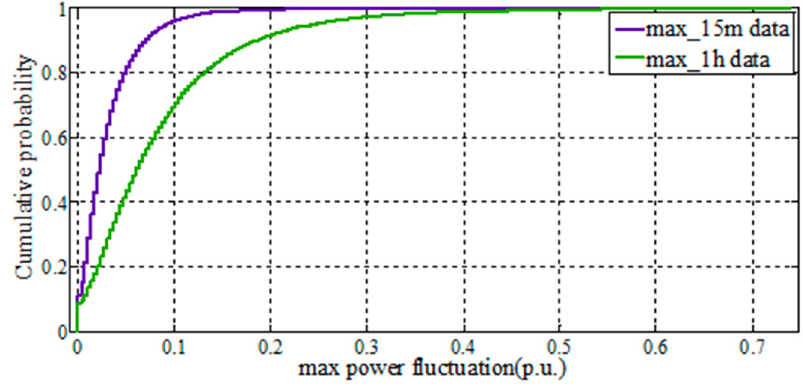
Figure2. Thecumulativeprobabilityofmaximumwindpowerfluctuationwithinadi ff Figure 2. The cumulative probability of maximum wind power fluctuation within a different time period.